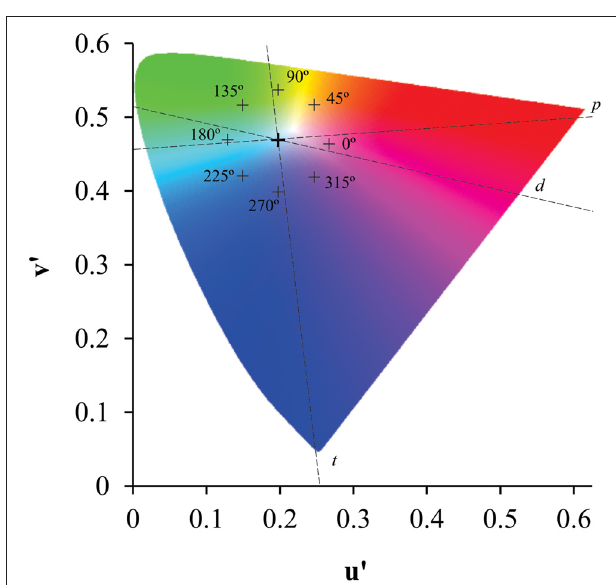
FIGURE 2 | Location of the target chromaticities in the CIE 1976 color diagram. Eight chromatic axes, equally spaced in 45 ◦ related to a horizontal axis that cross the reference chromaticity coordinate, had the length controlled by a staircase protocol to estimate the color discrimination threshold related to the background chromaticity. Crosses represent the greater chromatic vector in each axis. Dotted lines represent the protan ( p ), deutan ( d ) and tritan ( t ) confusion lines.